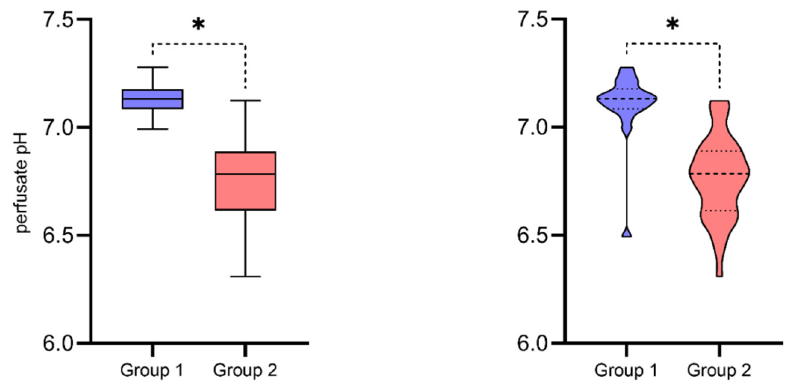
Figure 2. Perfusate pH in the study groups means & standard deviations; violin plots—medians, quartiles, and distribution. (Mann-Whitney U test, Group 1 (HMP) n 1 = 26 vs. Group 2 (SCS) n 2 = 40, N = 66, * p = 0.00000001 ).